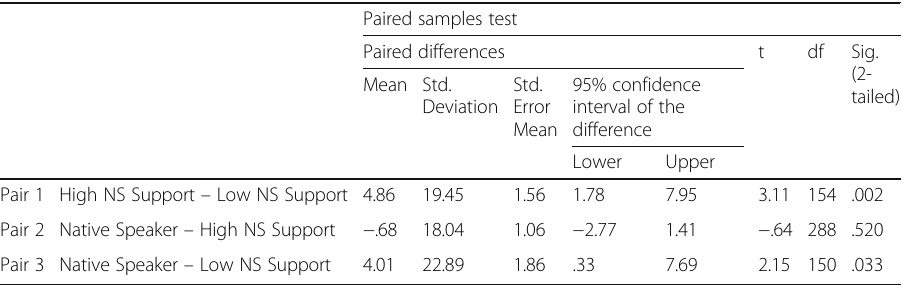
Paired samples test Paired differences tailed)Mean Std. Std. Deviation